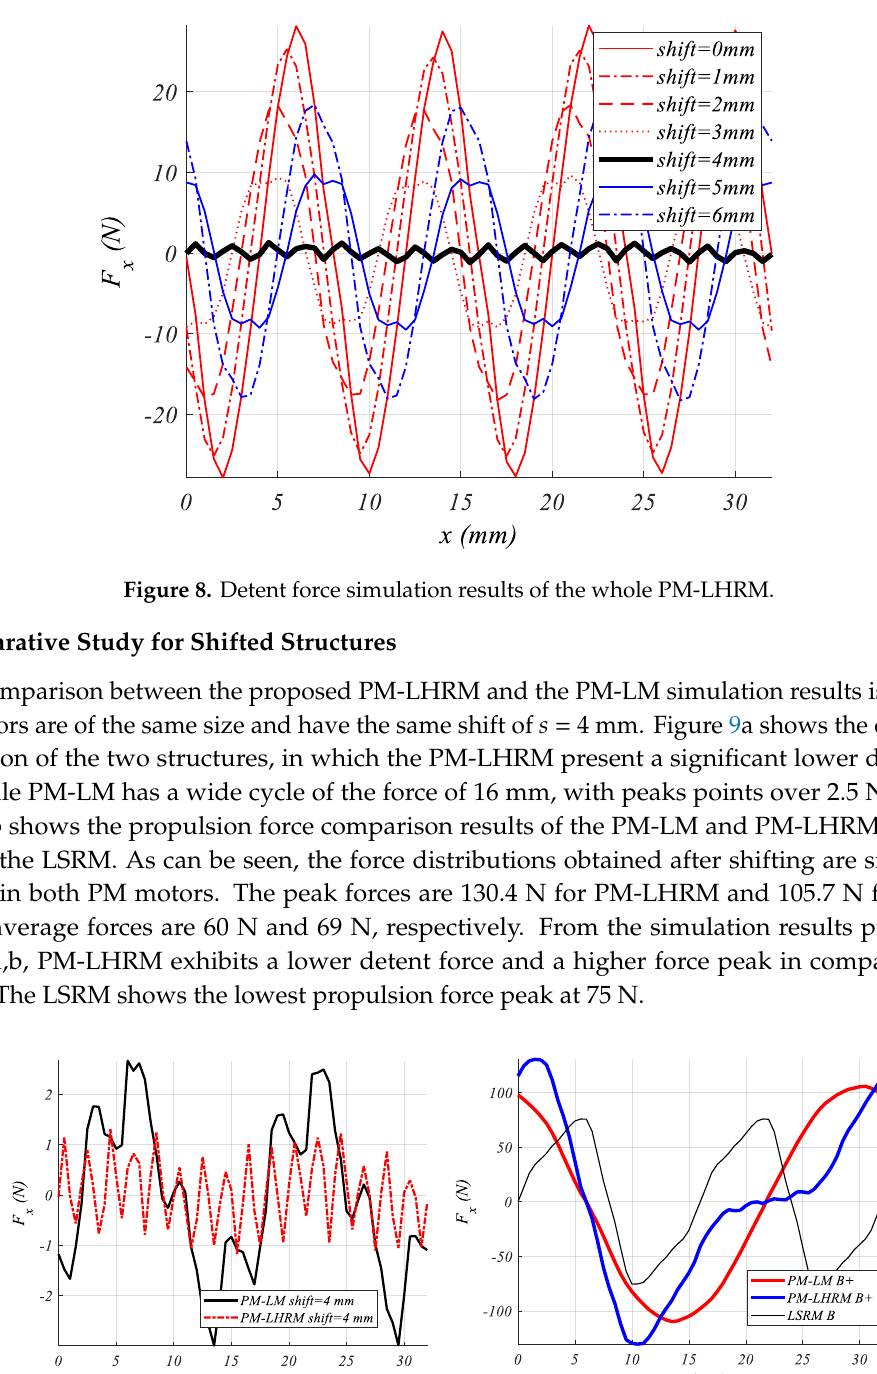
( b ) Figure 10. Phase force profiles and total force. ( a ) PM-LM at shift = 4 mm. ( b ) PM-LHRM at shift = 4 mm. Figure 11. Total force simulation comparison results for the PM-LHRM and PM –LM, s = 4 mm, and the LSRM at 10 A/mm 2 .